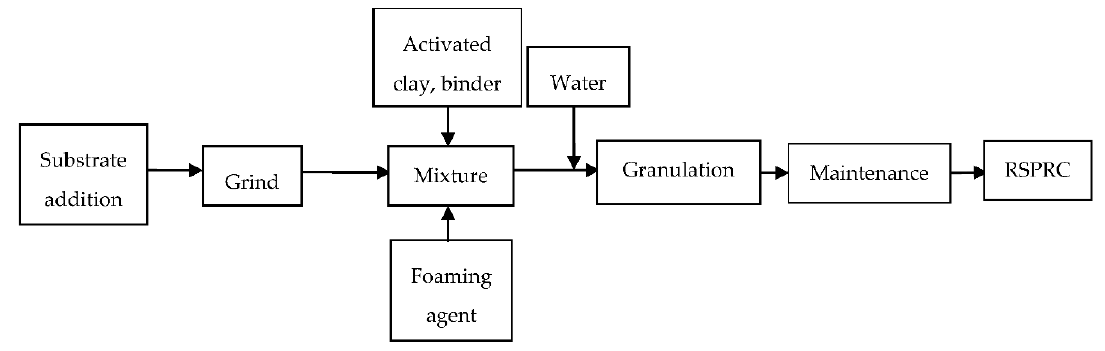
Figure 2. RSPRC preparation process.